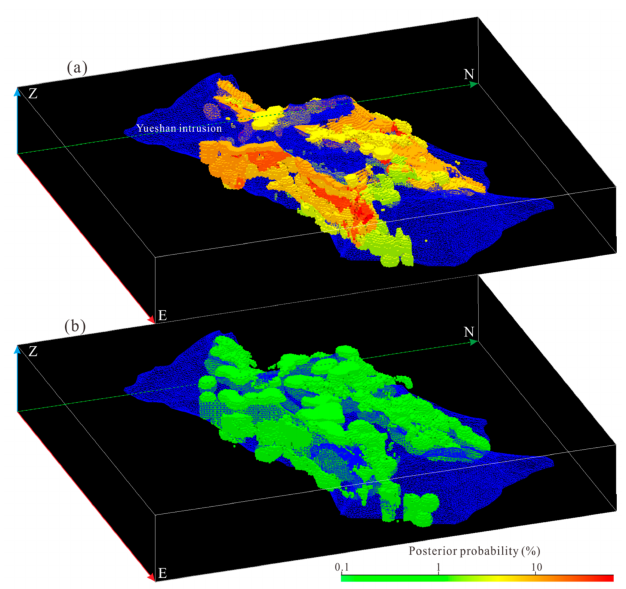
Figure 12. 3D combination of binary predictive maps with different posterior probability, showing ( a ) the high potential blocks, and ( b ) the medial potential blocks.